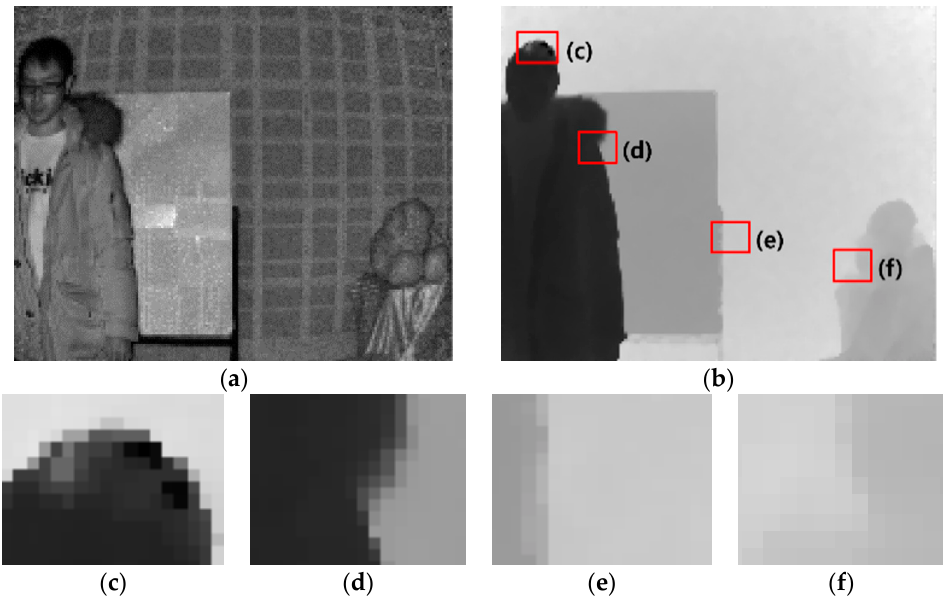
Figure 1. Problems in depth maps captured by time-of-flight (ToF) depth sensors. ( a ) Amplitude map, ( b ) distance image, ( c ) dark surface, ( d ) unmatched boundary, ( e ) shiny surface, and ( f ) unmatched boundary.